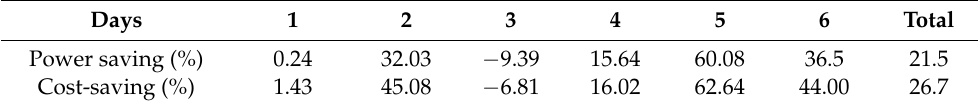
Table 3. Power and cost-savings for six days of winter